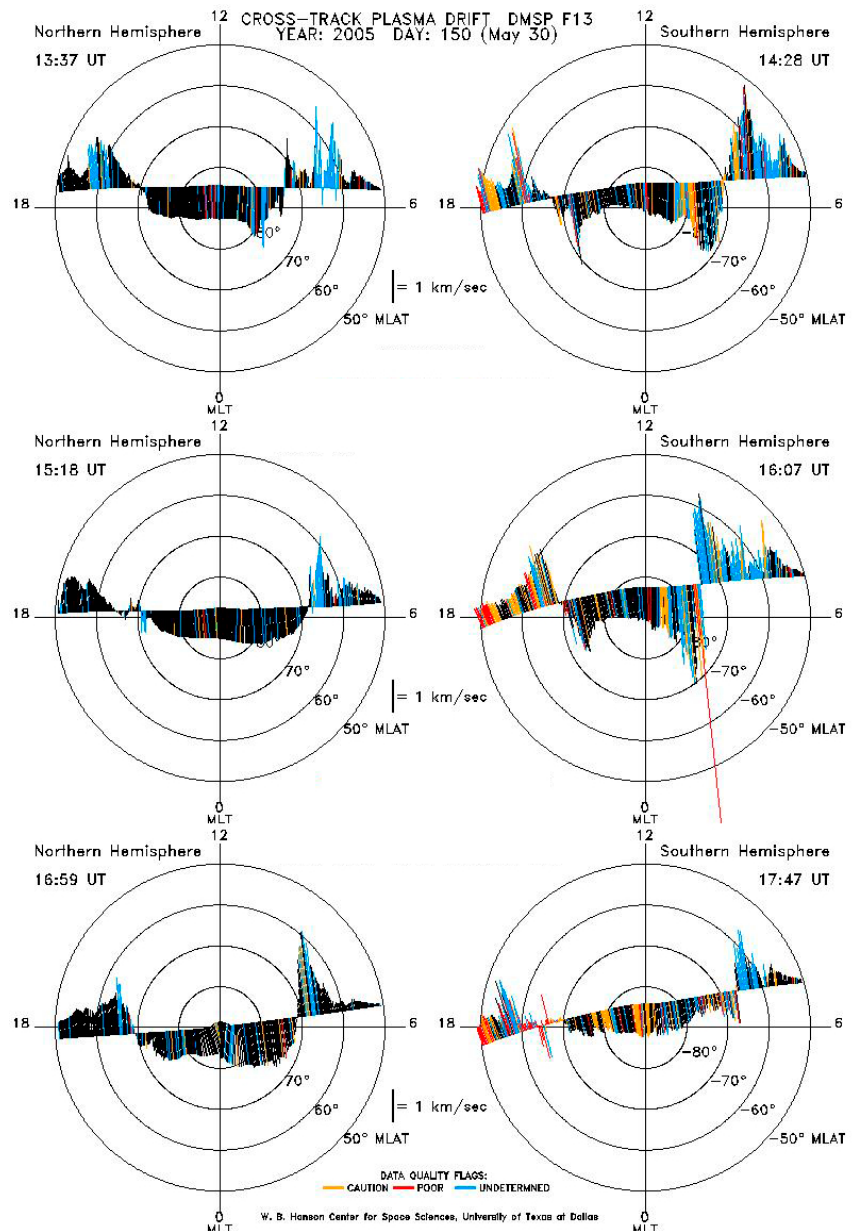
Fig. 9. DMSP F13 cross-track ion drifts on 30 May 2005 obtained during consecutive passes of the polar cap in the Northern (summer; left panels) and in the Southern (winter; right panels) Hemispheres during the interval 13:30–18:00UT. The centre times of each polar cap crossing are given. The coordinate system is